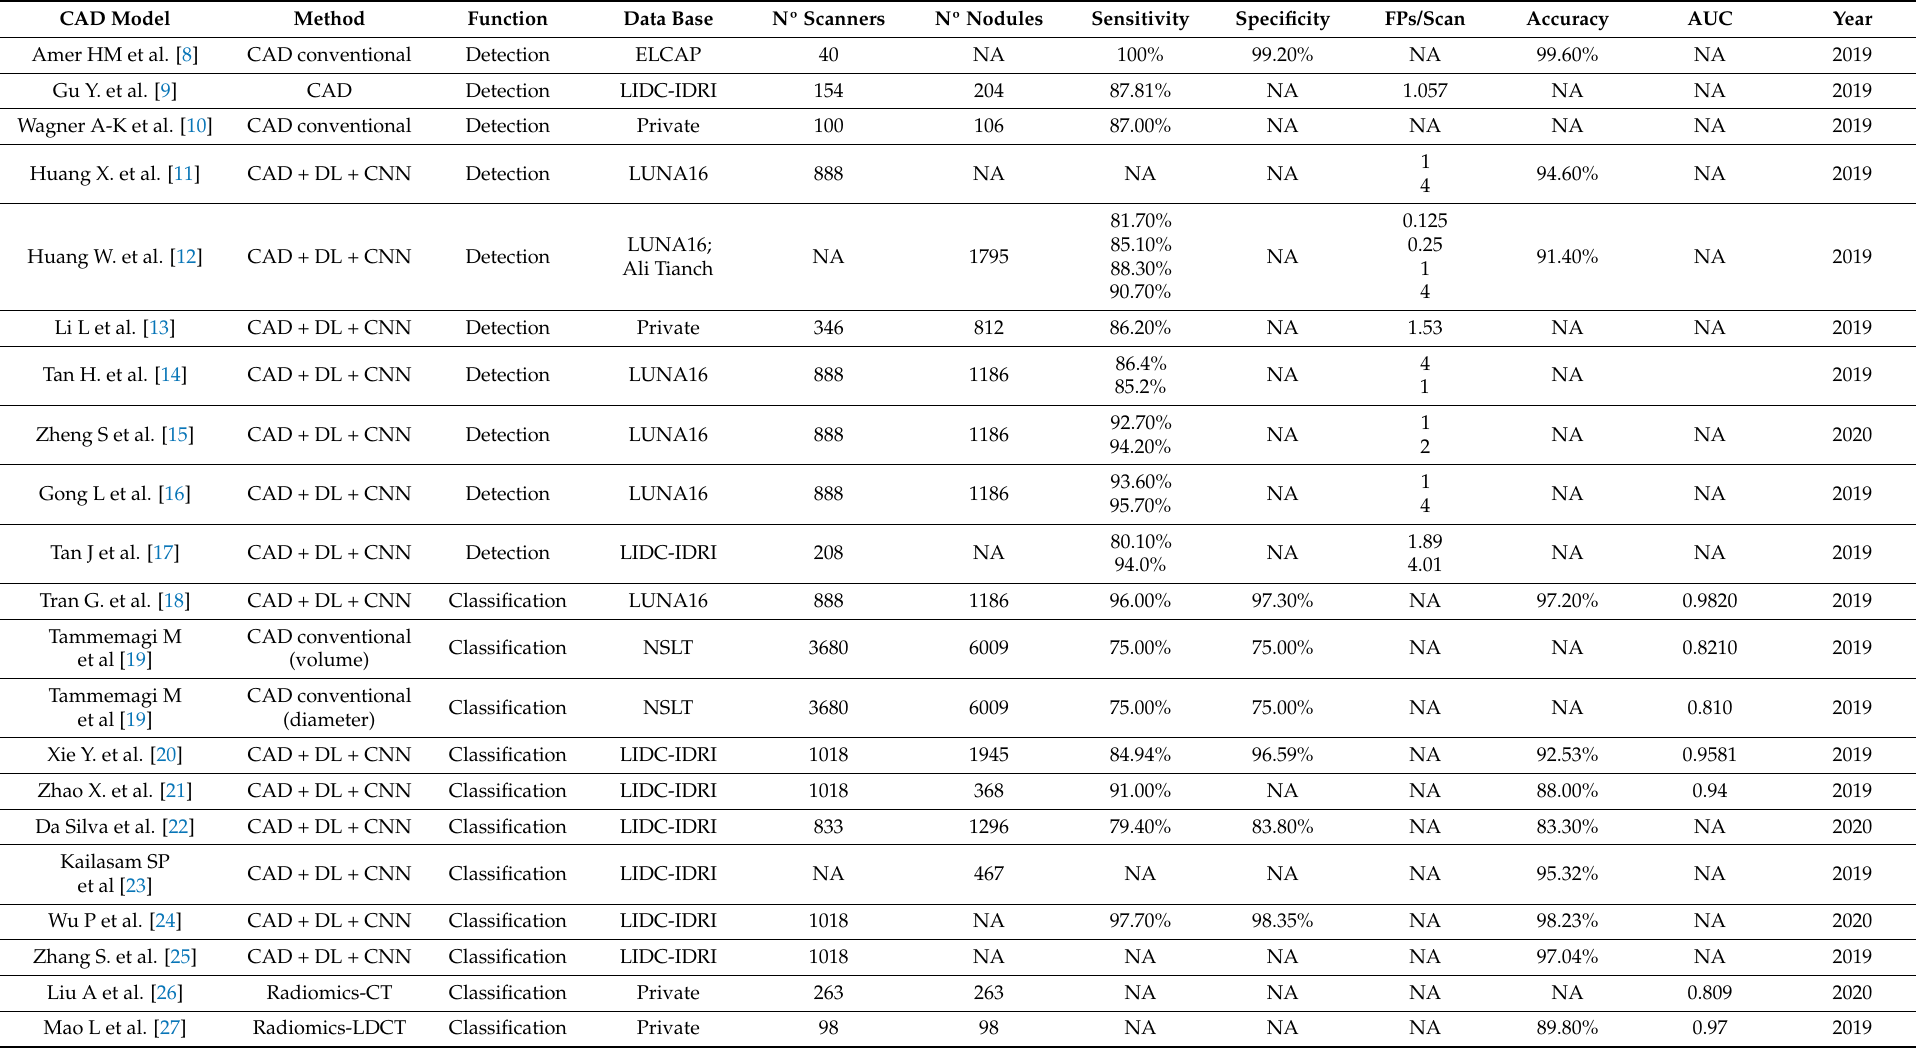
Table 1. CAD on lung cancer